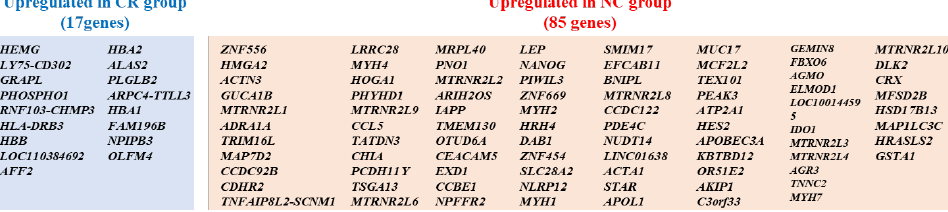
Figure 2. Analysis flow and differentially expressed genes in RNA sequences. ( A ): Among the 164 cases, 36 were negative for Hp infection and API2-MALT1 mutation. We classified them into 17 cases in which CR was achieved by eradication therapy (complete response [CR] group) and 19 cases in which CR was not achieved by eradication therapy (no-change [NC] group). Two cases were randomly selected from each of the CR and NC groups. We extracted RNA from tumor sites of the selected cases and conducted a comprehensive analysis via RNA sequencing to identify genes highly expressed in the CR group and NC group. We selected candidate genes that could be pre- dictors of eradication therapy efficacy and characterized the CR and NC groups. To determine the predictive marker genes among these candidate genes, we validated the expression of these genes using real-time PCR in 17 patients in the CR group and 19 patients in the NC group. ( B ): Vol- cano plot for gene expression. The X-axis represents log 2 transformed fold change, and the Y-axis represents -log 10 transformed significance. Red points represent upregulated DEGs. Blue points represent downregulated DEGs. Gray points represent non-DEGs. ( C ): List of differentially expressed genes